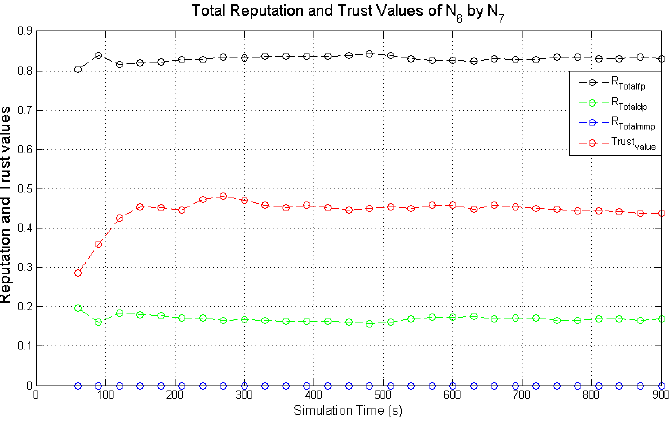
Figure 16. N 6 is benevolent and dishonest, N 7 is benevolent and honest.